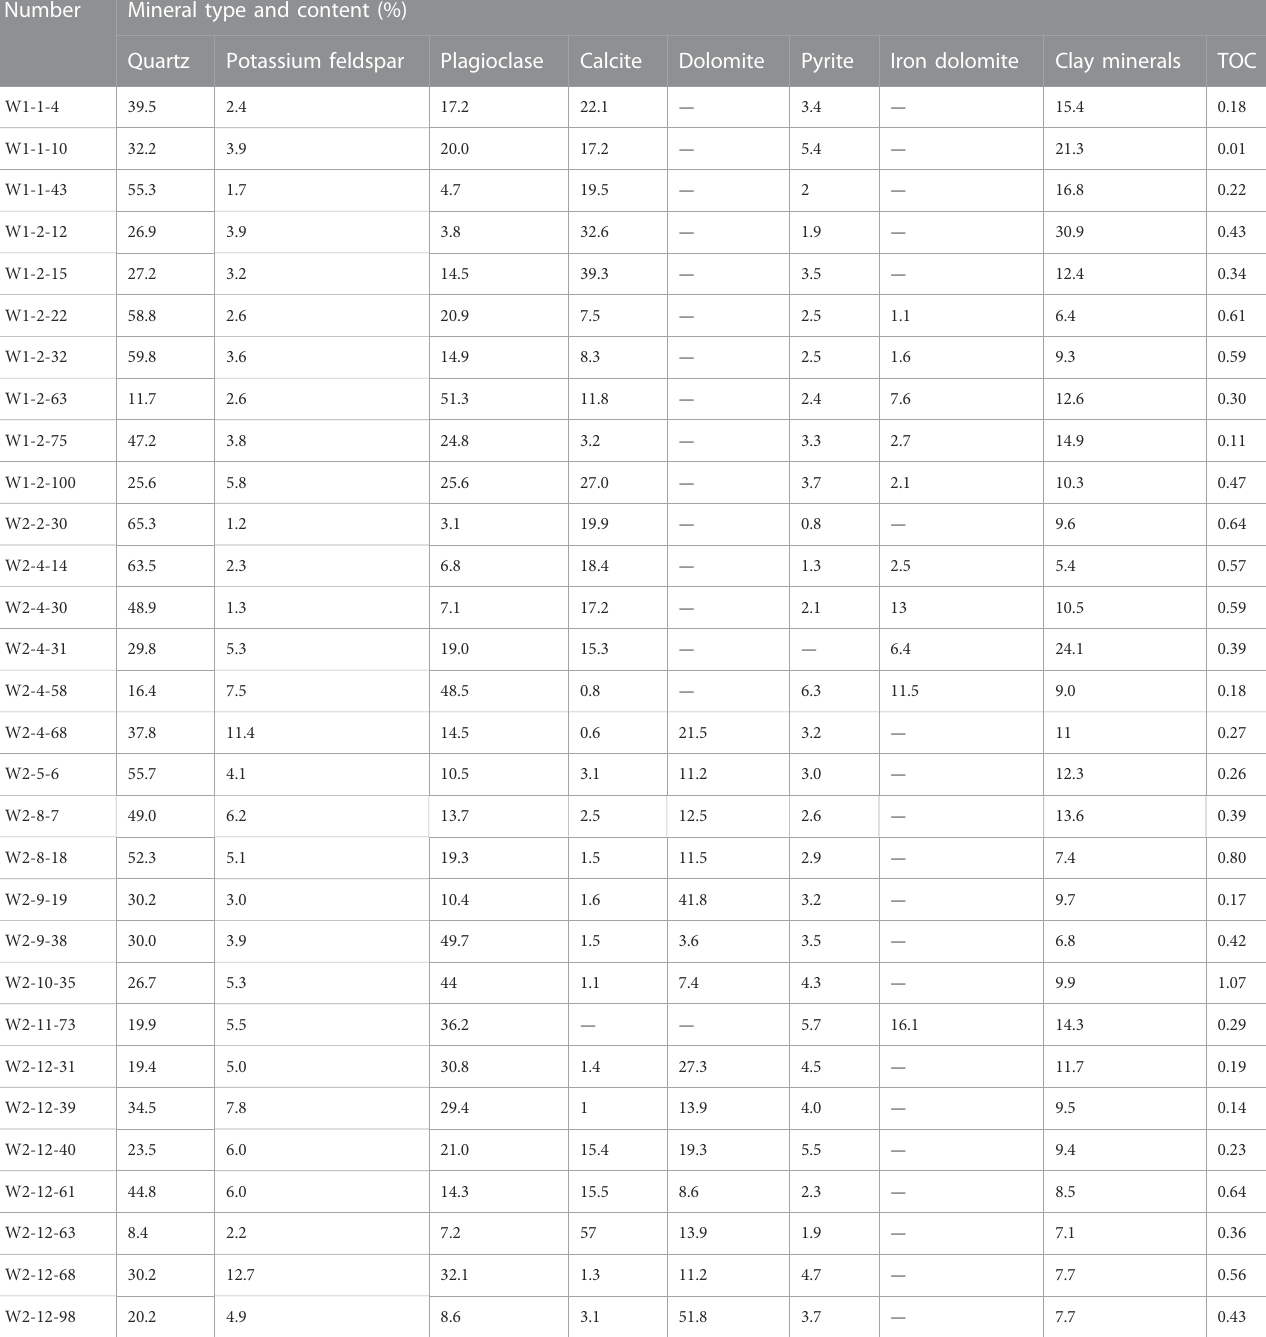
TABLE A1 Mineral composition and TOC content of shale samples from Fengcheng formation in Mahu Sag, Junggar